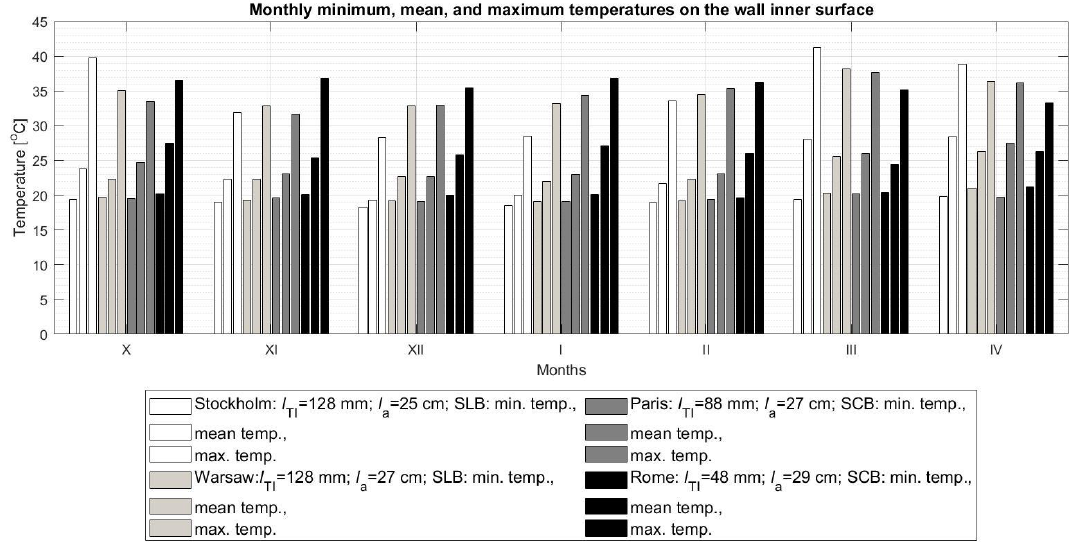
Figure 13. Comparison of monthly heating times for the SWs with the TI thickness and AL parameters and materials proposed for the considered locations.